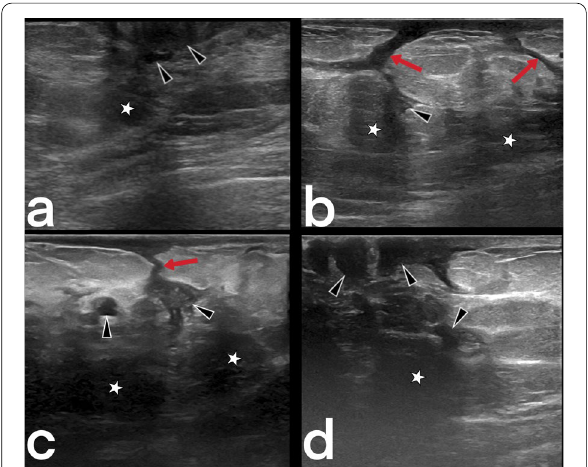
(Fig. 19). Myocardial involvement is asymptomatic but can be detected postmortem [3, 20]. Breast